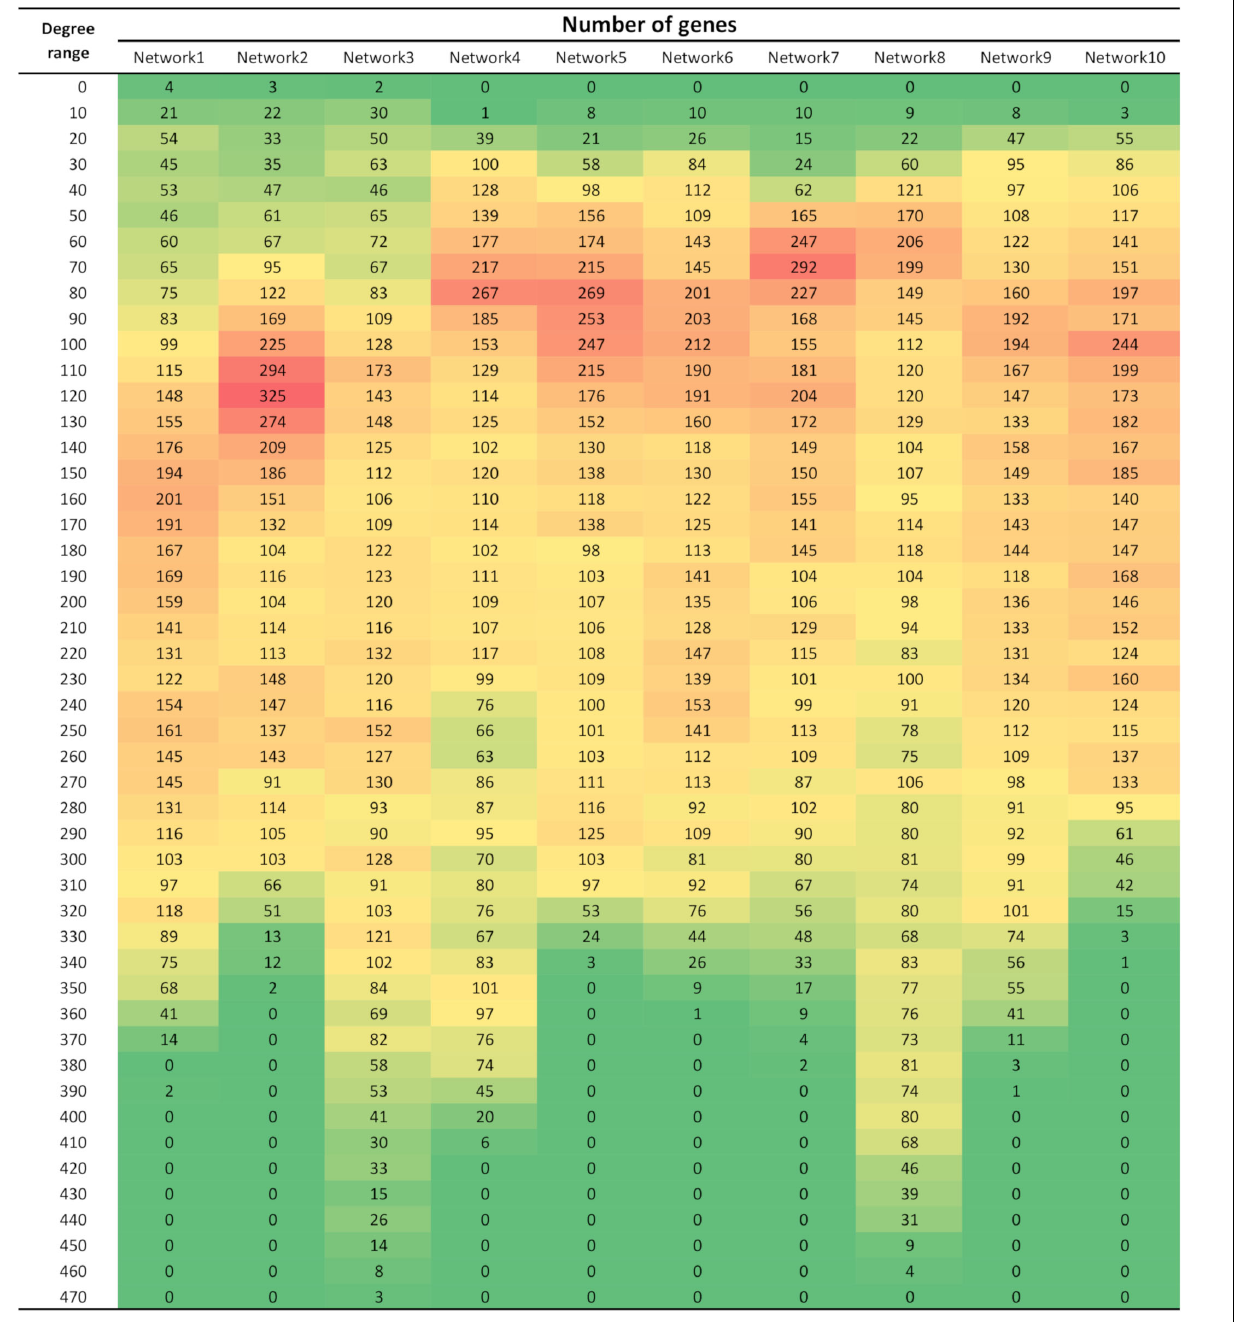
FIGURE 1 | Number of genes within different degree ranges in each of the 10 networks. Degree refers to the number of significant connections per gene. All networks were comprised of 4,133 genes/nodes.